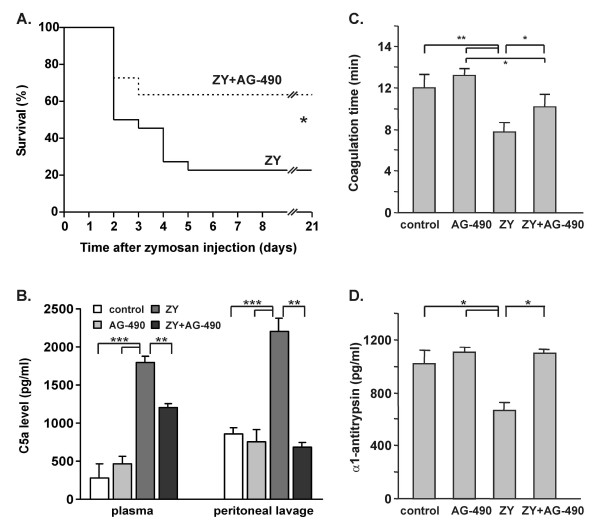
Effect of AG-490 on zymosan-induced inflammation. A, The administration of AG-490 (5 mg/kg) increased the survival rate of mice injected with 1 mg/g body weight of zymosan (n = 15/group). B, AG-490 inhibited the level of C5a in peritoneal lavage and in plasma 4 h after zymosan injection. C-D, AG-490 rendered the time of coagulation and the plasma level of α1-antitrypsin to normal range 4 h after the induction of shock. The data represent mean ± SD from 3 independent experiments with 5 mice/group; *p < 0.05, **p < 0.01 and ***p < 0.001; Control groups of healthy mice were treated with vehicle (control) or AG-490 (AG-490), shock mice were treated with vehicle (ZY) or with AG-490 (ZY+AG-490); ANOVA test was used to analyze the survival data and Student's t test to compare other parameters.